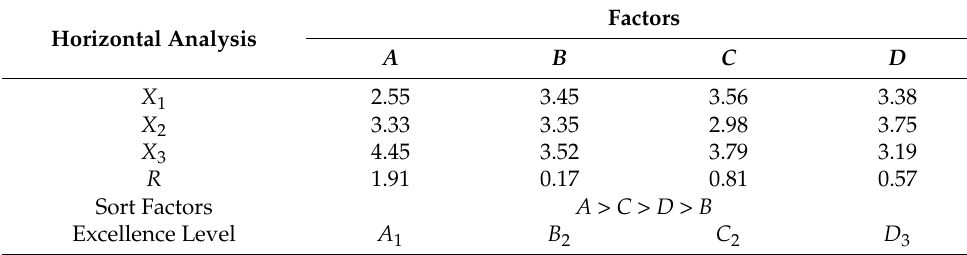
Table 5. Range analysis of color difference of dyed red-heart Chinese fir wood before and after soaking in water for 6